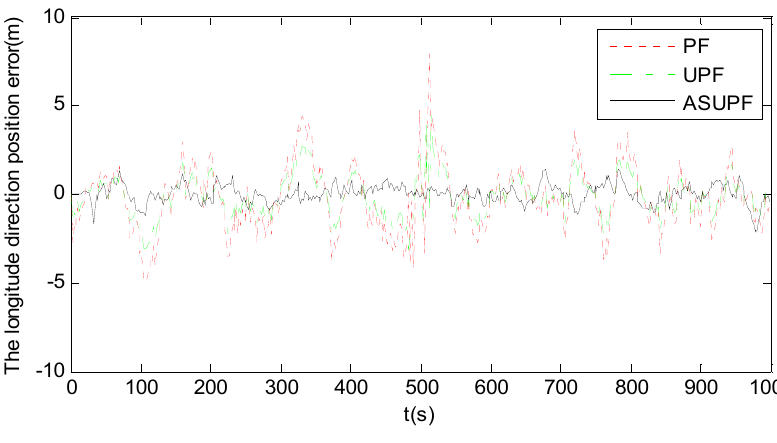
Figure 6. The longitude errors of PF, UPF and ASUPF ( M = 200). Table 3. The mean values of the longitude RMSEs for EKF, UKF, UPF and ASUPF. Filter Mean Value of Longitude